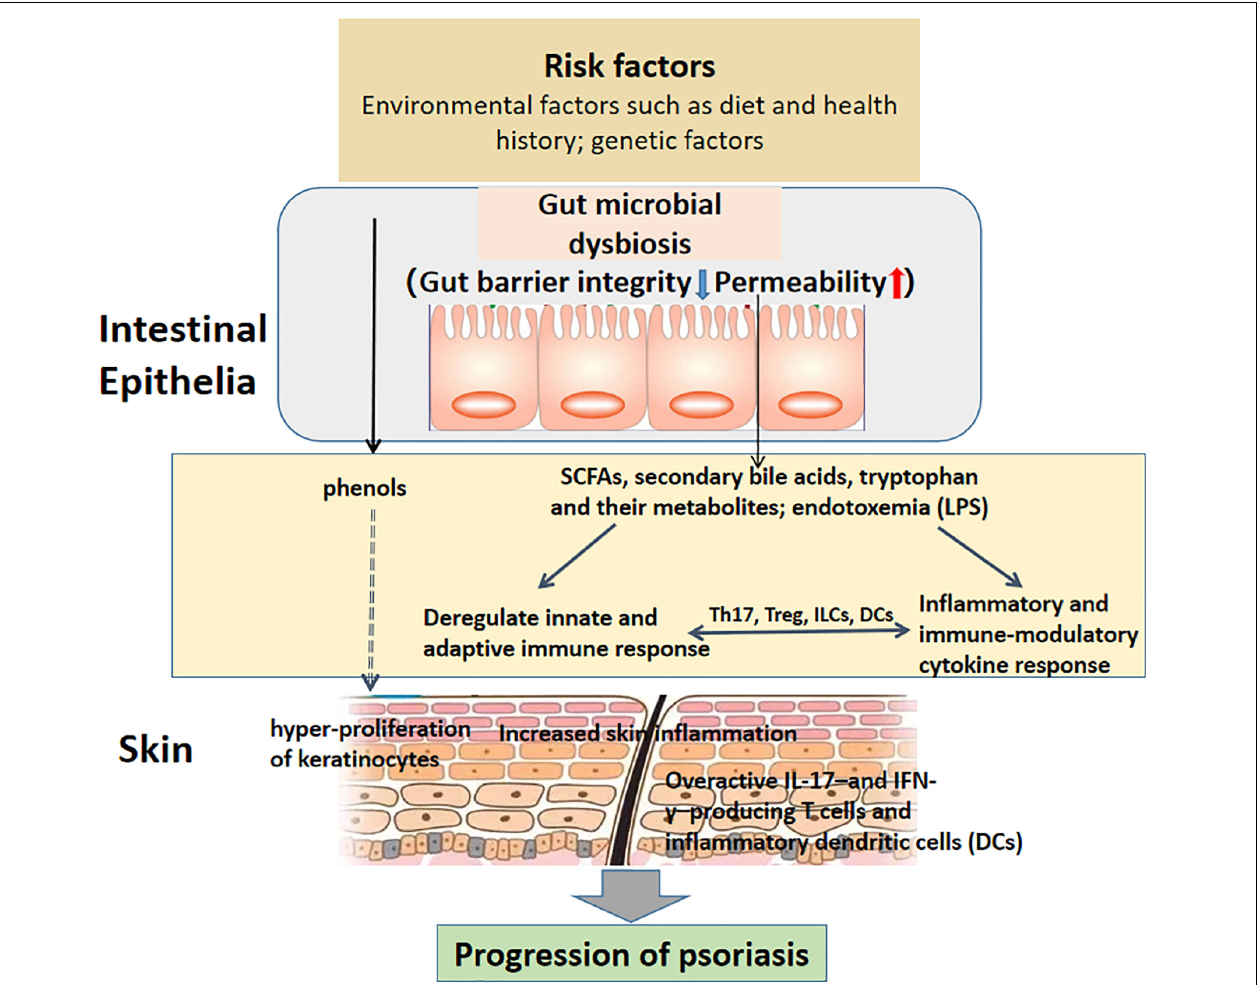
FIGURE 1 | The putative relationship between gut dysbiosis and psoriasis onset and progression. Intestinal barrier function is maintained by group 3 innate lymphoid cells (ILC3s) and IL-17- and IL-22-producing T helper 17 (Th17) cells, which modulate antimicrobial peptide secretion by intestinal epithelial cells (IECs) and IgA production in the gut (Hirota et al., 2013; Kruglov et al., 2013). Moreover, dendritic cells (DCs) participate in microbiota sensing via the Mincle-Syk axis to regulate IL-17 and IL-22 production and promote intestinal barrier integrity (Martinez-Lopez et al., 2019). Host- and microbiota-derived factors induce gut microbe dysbiosis, including disruption of gut barrier integrity and increased permeability, as well as alterations in microbial metabolites such as SCFAs, secondary bile acids, tryptophan, lipopolysaccharides (LPSs) and phenols, thus disturbing immune homeostasis via a low-grade chronic inflammatory process. For example, the intestinal microbiota promotes psoriasis-like skin inflammation by enhancing the Th17 response, and regulatory T cell (Treg) levels decrease in psoriasis patients, leading to an imbalance between effector T cells and suppressor T cells (Zakostelska et al., 2016; Komine, 2020). Th17 cell differentiation requires IL-6 and transforming growth factor- β (TGF- β ) from DCs in an antigen-dependent manner (Ivanov et al., 2006; Persson et al., 2013). In contrast, activation of ILC3s requires the release of IL-23 by myeloid cells to produce IL-22 and/or IL-17, which is antigen dependent (Satpathy et al., 2013; Longman et al., 2014). Increased numbers of ILC3s exist in the circulating blood of psoriatic arthritis patients, as well as the lesional and non-lesional skin of psoriasis patients (Soare et al., 2018). Phenols, as metabolites of aromatic amino acids produced by gut bacteria and regarded as bioactive toxins and serum biomarkers of a disturbed gut environment, have the ability to influence keratinocyte differentiation in the skin, but the underlying mechanism remains to be explored (Miyazaki et al., 2014). The involvement of immune cells and their active factors and intestinal microorganisms and their metabolites promotes the progression of